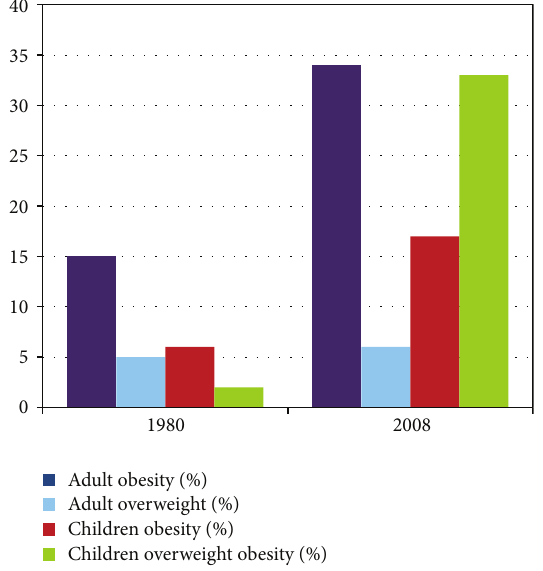
Figure 2: Prevalence’s trend of overweight and obesity in USA population (1980–2008)